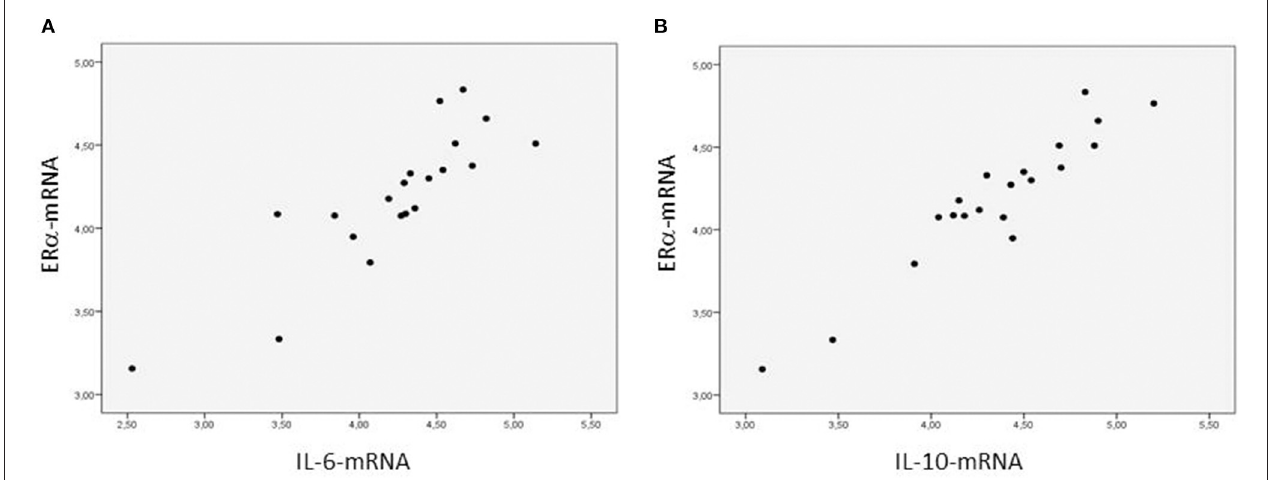
FIGURE 1 | Relationship between the myocardial expression of ER α - and IL6-mRNA (A) and between the myocardial expression of ER α - and IL10-mRNA (B) . N = 20. Spearman correlation coefficient = 0.893 (A) and = 0.880 (B) , p < 0.0001, respectively. The mRNA expression of the target gene is corrected for that of 18S.